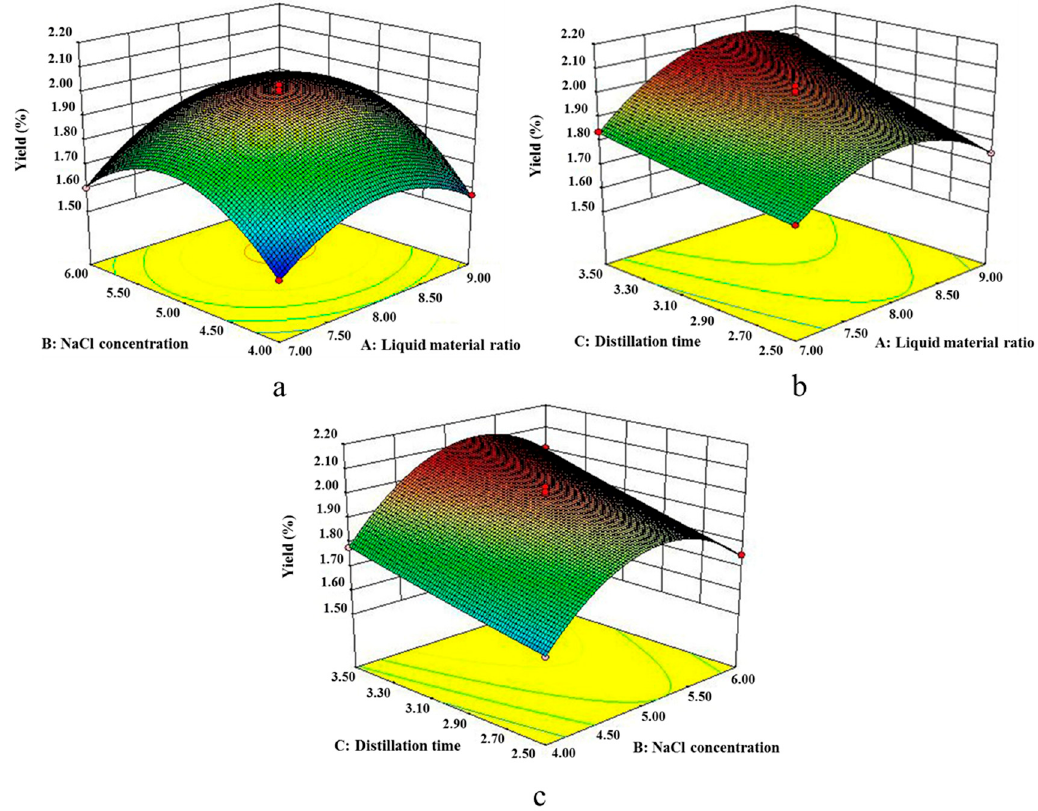
Figure 1. Response surface plot of ( a ) B and A; ( b ) C and A; ( c ) C and B, and their mutual interaction onthe yield of GOEO. A, B, and C represent liquid material ratio, NaCl concentration, and distillation time, respectively.